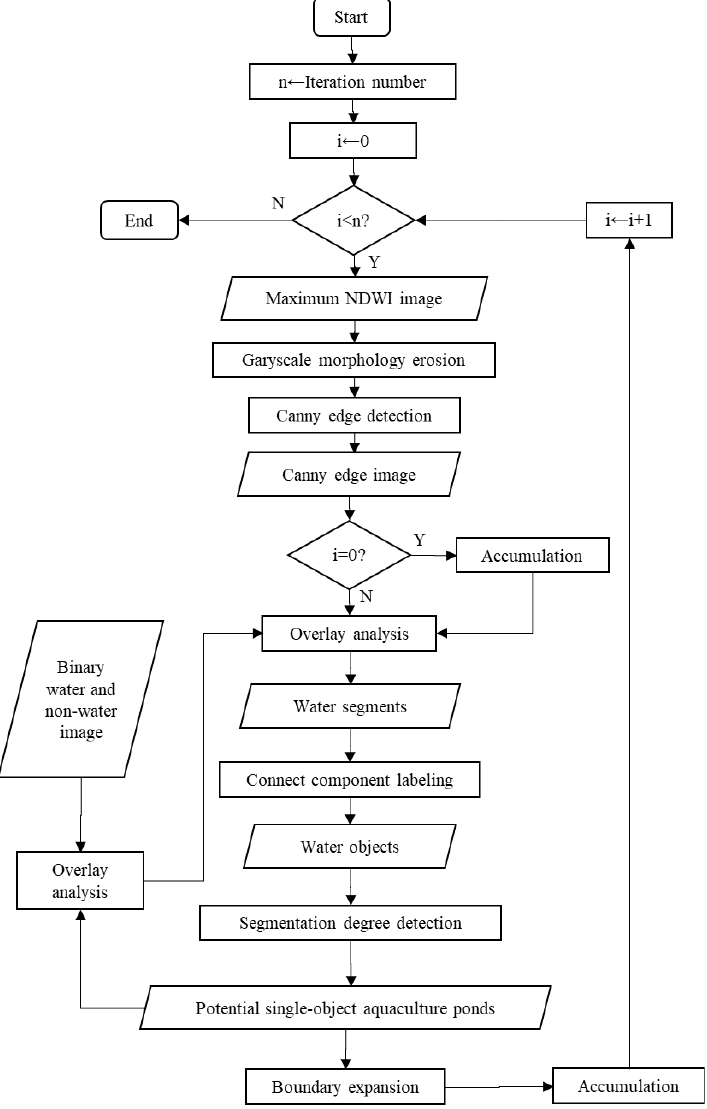
Figure 4. Flowchart of the iterative algorithm combining grayscale morphology and Canny edge detection (Note: Y = Yes; N = No).